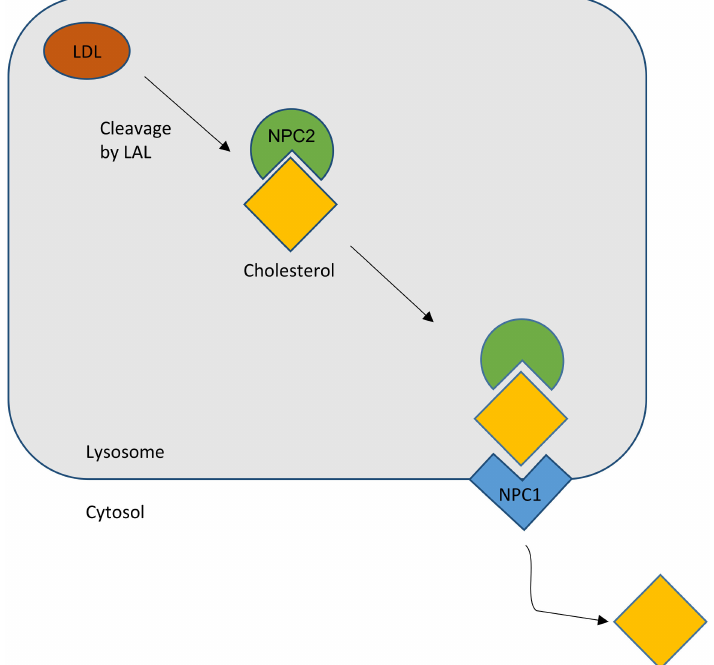
Figure 1. Schematic outline of the normal cholesterol tra ffi cking via NPC2 and NPC1 interaction. LAL, lysosomal acid lipase (courtesy of Ren é Thiemer, modified after